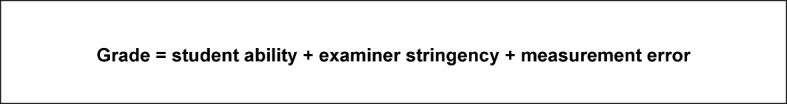
The facets of the variance analysis conducted in the study.